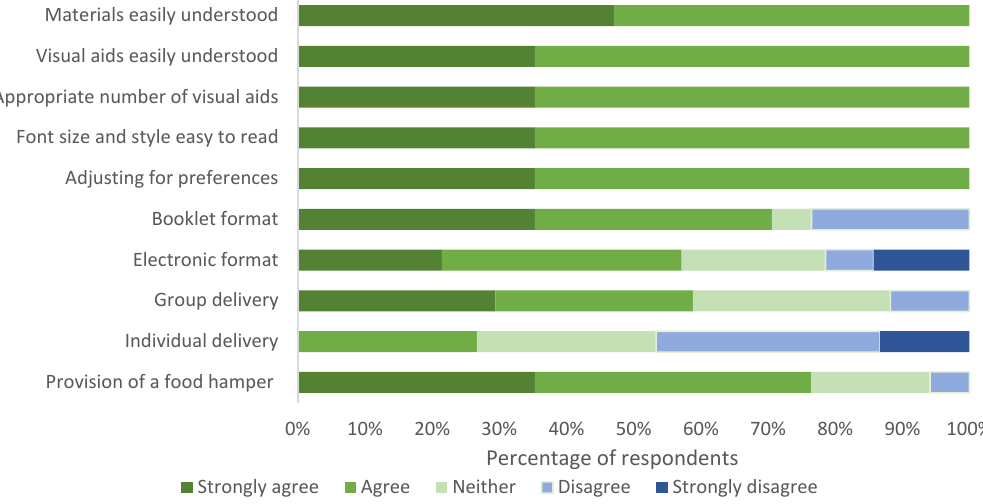
Figure 3. Consumer research group participant ( n = 17) opinions on the ease of use, effectiveness, applicability and format of AusMed diet program materials.